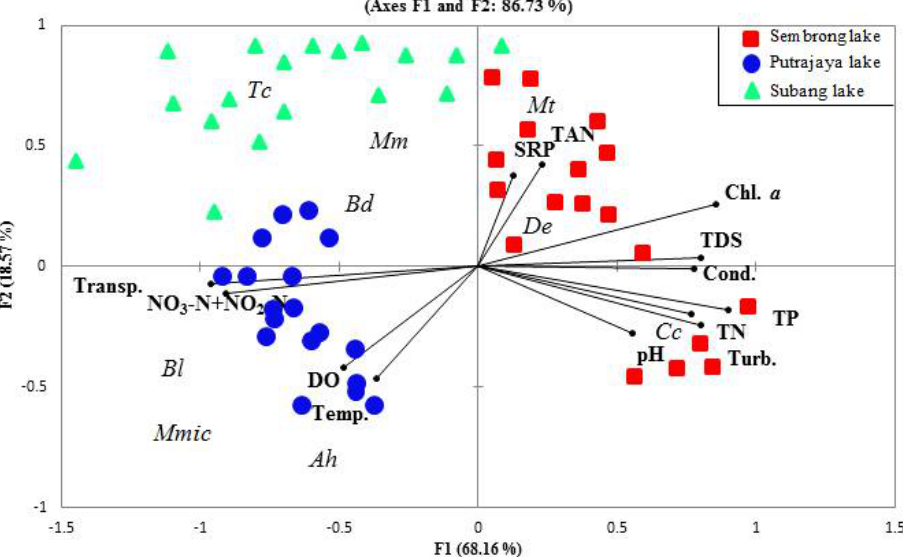
Figure 7. Bi-plots of the canonical correspondence analysis (CCA) for microcrustacean species and physical and chemical parameters showing the distribution of microcrustacean in relation to environmental conditions in different lakes. TP = total phosphorus, TDS = total dissolved solid, DO = dissolved oxygen, TAN = total ammonium nitrogen, SRP = soluble reactive phosphorus, TN = total nitrogen, NO 3 -N + NO 2 -N = nitrate-N + nitrite-N, Chl. a = chlorophyll a , Cond. = conductivity, Turb. = turbidity, Temp. = water temperature, Transp. = transparency, Cc = Ceriodaphnia cornuta , Bl = Bosmina longirostris , Bd = Bosminopsis dietersi , De = Diaphanosoma exsicum , Mmic = Moina micrura , Ah = Anthalona harti , Tc = Thermocyclops crassus , Mm = Mongolodiaptomus malaindosinensis , Mt = Mesocyclops thermocyclopoides.